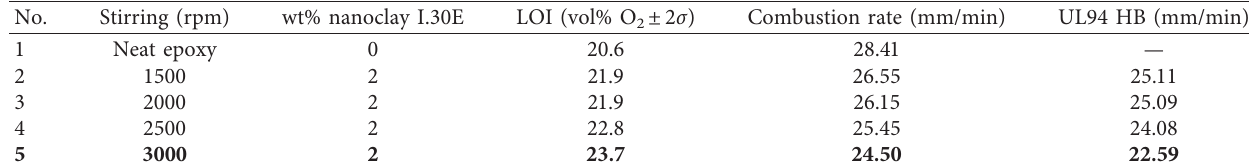
Table 6: Flame-retardant properties of epoxy Epikote 240/nanoclay I.30E nanocomposite